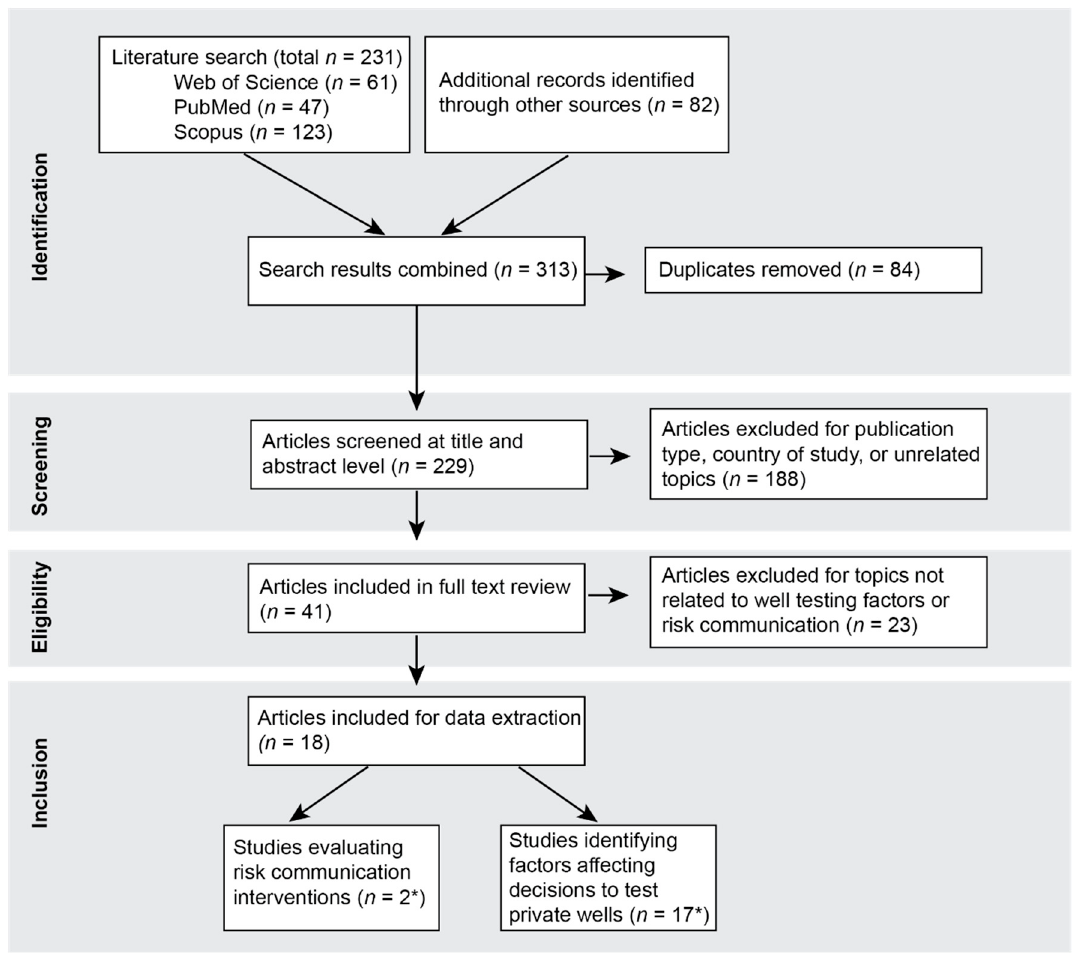
Figure 2. Preferred Reporting Items for Systematic Reviews and Meta-Analysis (PRISMA) flow diagram for the stages of selecting articles for inclusion. * One article addressed both risk communication interventions and factors affecting decisions to test private wells.